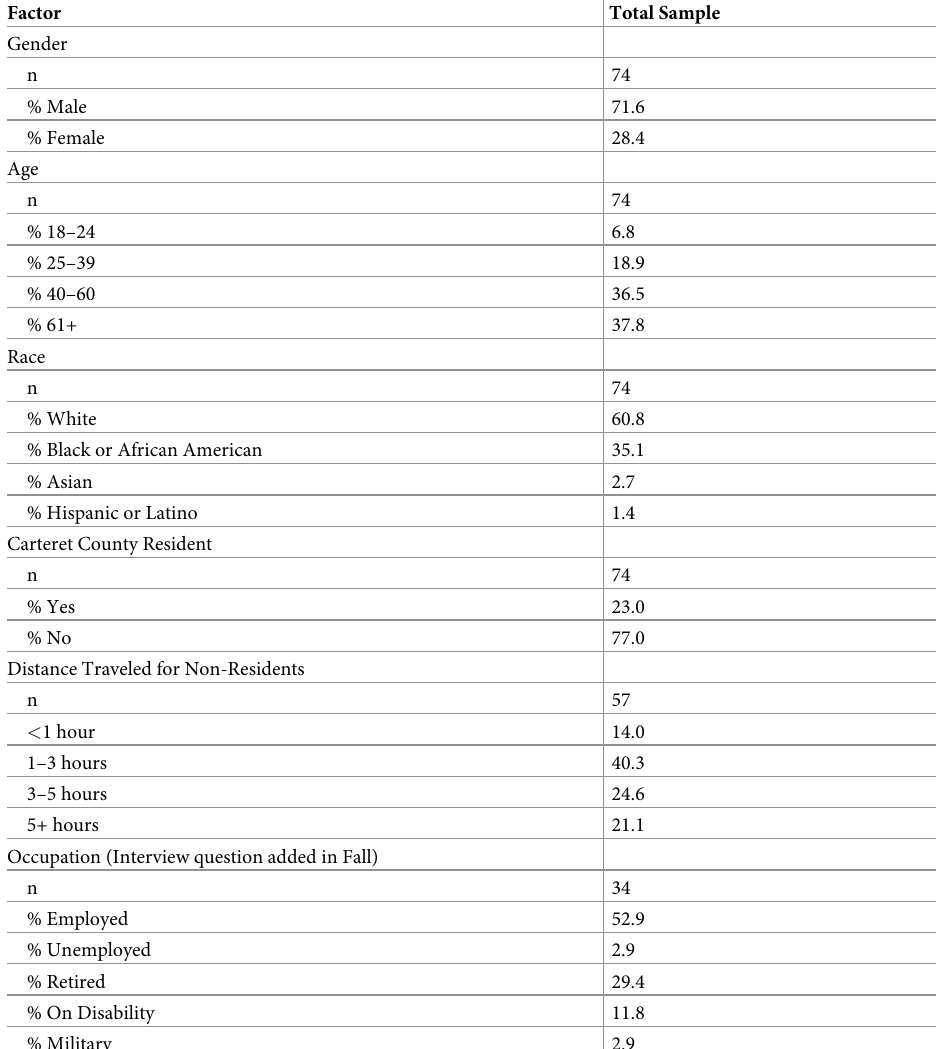
Table 1. Characteristics and demographics of fishers